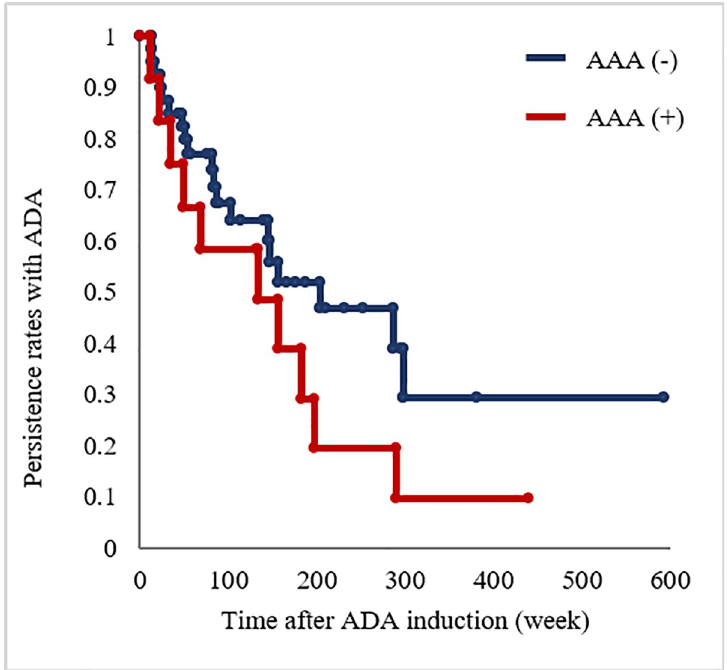
Fig 1. Kaplan–Meier curves of time to ADA discontinuation in patients in the AAA-negative group vs. those in the AAA-positive group ( P = 0.023 by log-rank test). ADA, adalimumab; AAA, anti-adalimumab antibody.